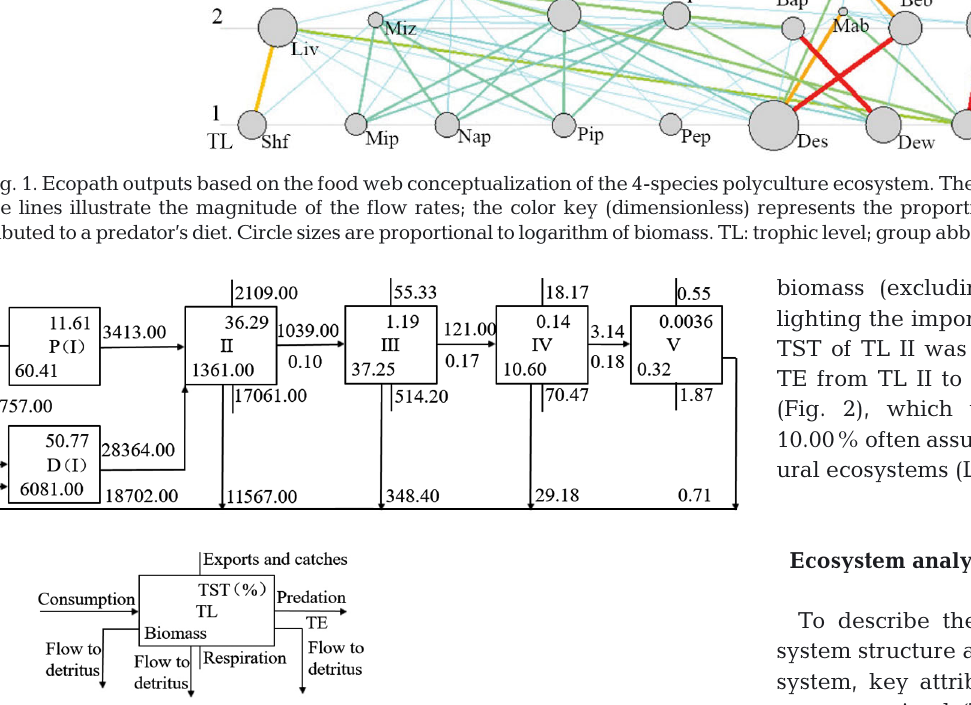
Fig. 2. Aggregation of flows and biomass (kJ m –2 90 d –1 ) in the 4-species poly- culture ecosystem into discrete trophic levels (I to V) sensu Lindeman (1942). D: detritus; P: primary producers; TL: trophic level; TE: transfer